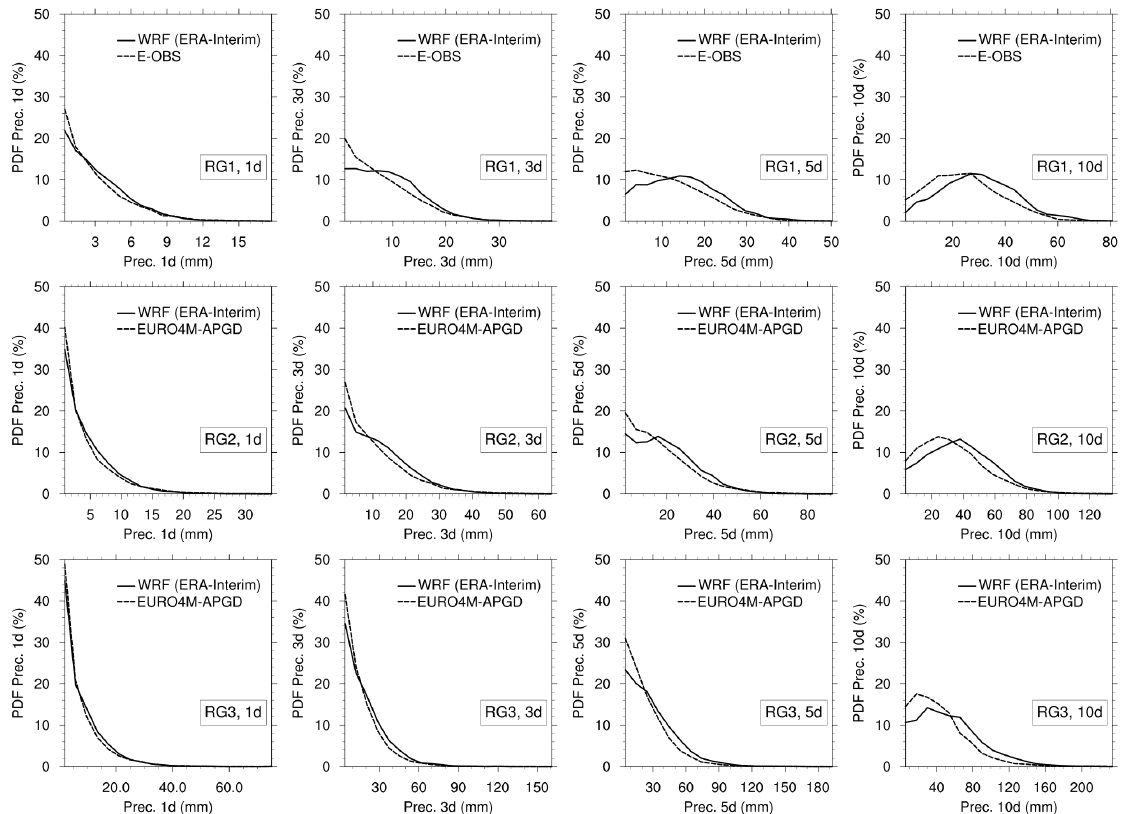
Figure 7. Probability density functions for precipitation intensities from the WRF simulation and from the E-OBS/EURO4M-APGD observation data for RG1 (top row), RG2 (center row), and RG3 (bottom row) in mm per 1 day/3 days/5 days/10 days (moving window, from left to right). The bin sizes for the PDFs are for RG1: 0.9, 2.0, 2.6, and 4.1 mm, for RG2: 1.8, 3.3, 4.6, and 6.9 mm, and for RG3: 3.8, 8.3, 9.9, and 12.0